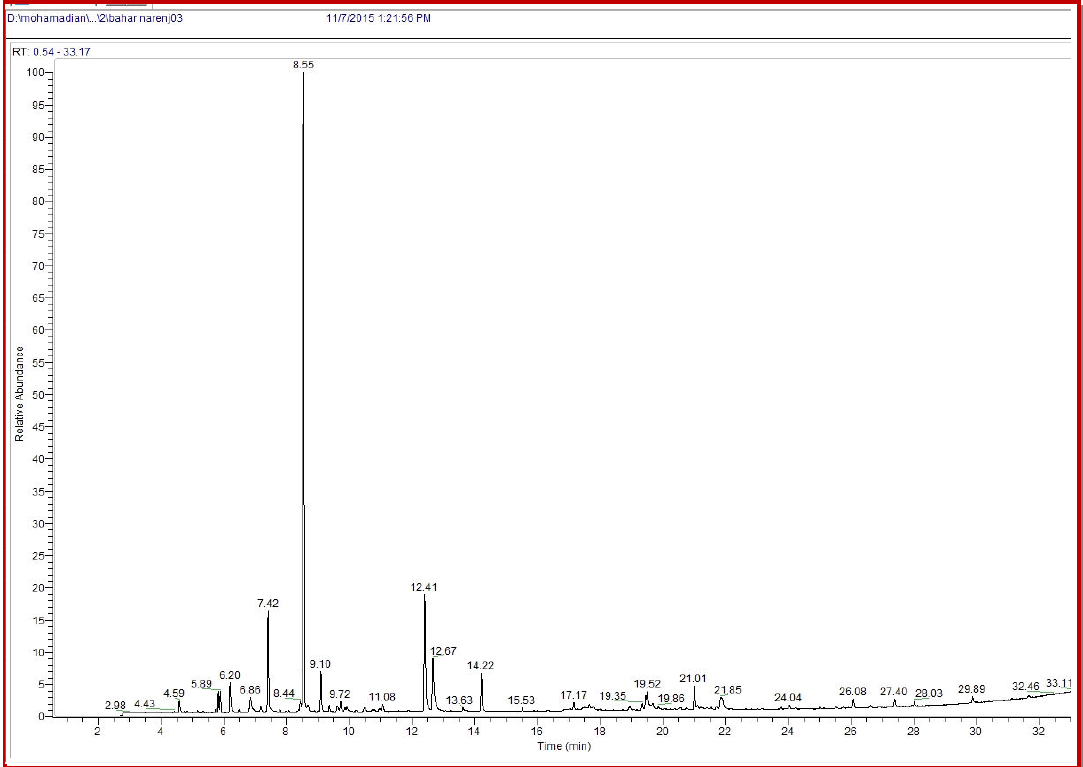
Figure 1: Chromatographic spectrum of C. aurantium essential oil